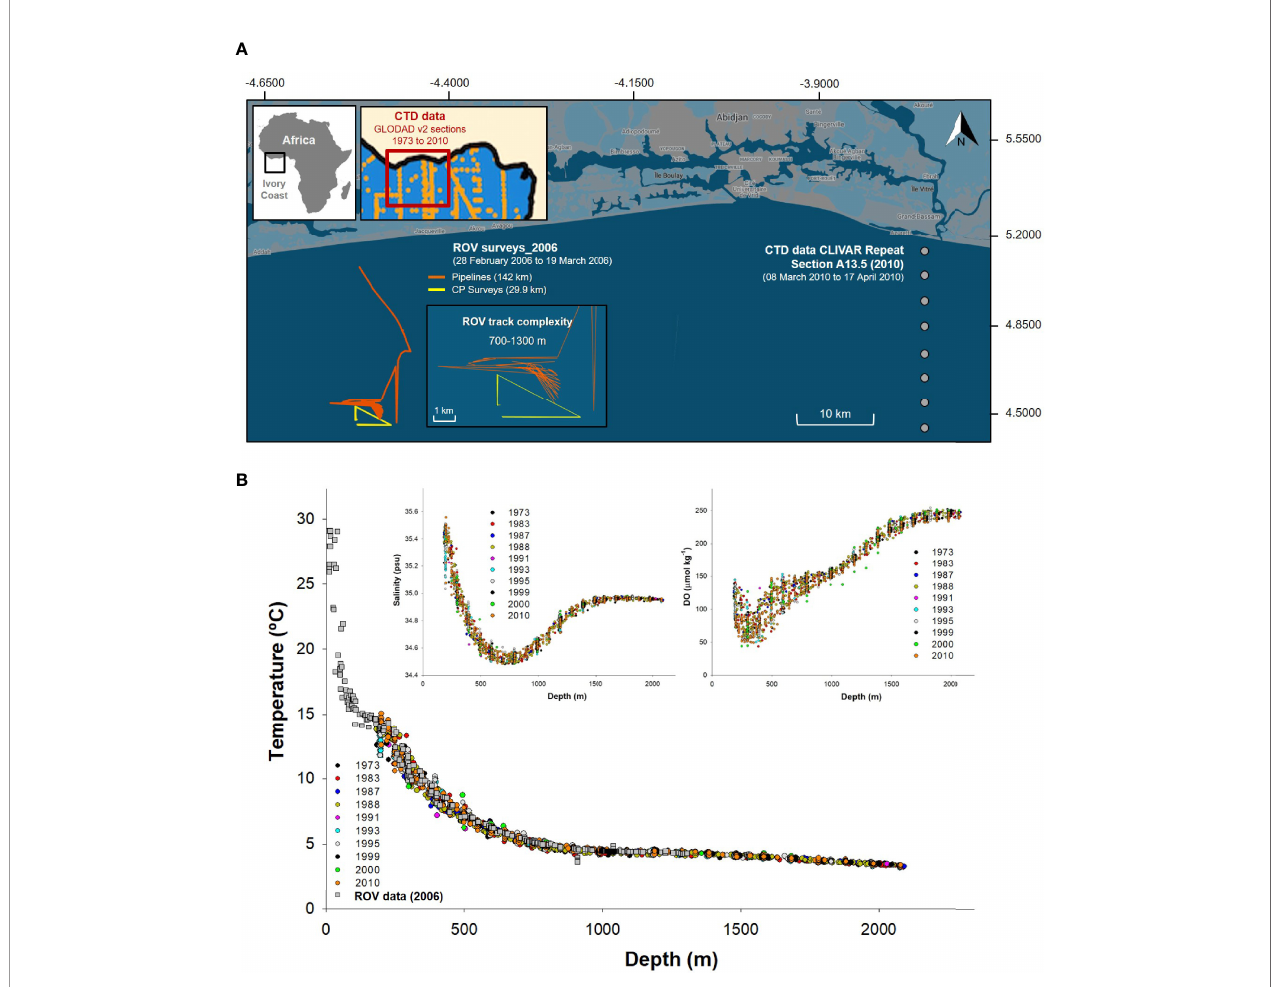
FIGURE 2 | Detailed map of the remotely operated vehicle (ROV)-based surveys. Also included is the wider area from which water column pro fi le data from GLODAP v2 were derived. Pro fi les of benthic environmental data vs. depth over time to justify the GLODAP v2 data use. (A) Detailed ROV-based survey map with tracks to help understand the complexity and positioning of the CLIVAR Repeat Section A13.5 2010 (closest year to 2006 with reliable data available) with respect to the ROV survey. Also included maps of the GLODAP v2 (https://www.nodc.noaa.gov/ocads/oceans/GLODAPv2/) transects from 1973 to 2010 used to understand water column pro fi les environmental data variability in the area. (B) Near-bottom water pro fi les and ROV-derived temperature, salinity, and dissolved oxygen (DO) pro fi les, from 1973 to 2010, were compared to justify the use of 2010 data to analyze the 2006 events. All 11 pro fi les were remarkably similar near the seabed, despite covering an area wider than 500 km across the Ghanaian Ivory Coast continental margin. The base map was retrieved from https://www.google.com/maps/ d/u/0/edit?hl=en&mid=118kWIJnxdfJ_aa79Qq6JFqf-aedacoi7&ll=5.049633727701252%2C-4.504481&z=12, and then survey data were plotted on it (Google,